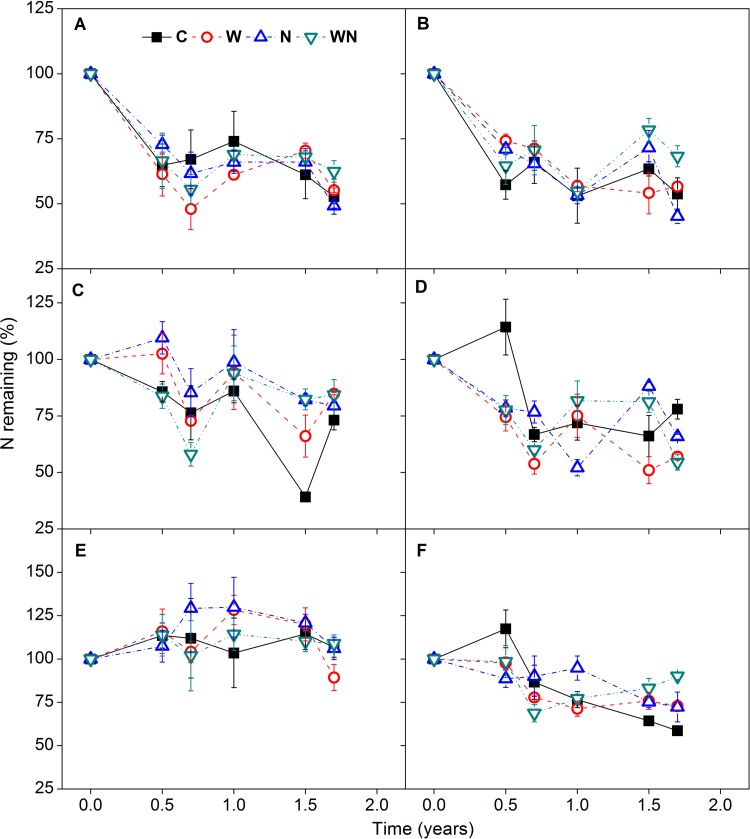
Residual N (as percentage of initial content) of E. oxyrrhynchum (A), S. santolinum (B), S. subcrassa (C), P. communis (D), K. caspia (E), and N. sibirica (F) during the decomposition process under control (C), water (W), nitrogen (N), and water plus nitrogen addition (WN) treatments (experiment I).Vertical bars represent standard errors (n = 3).